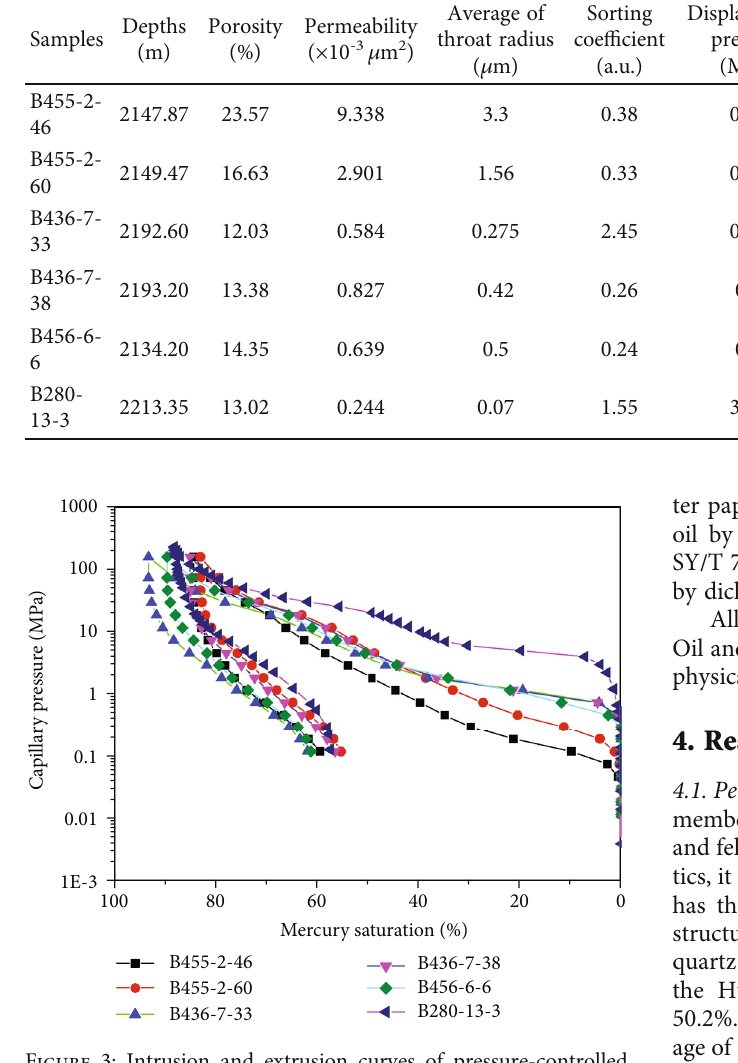
Figure 3: Intrusion and extrusion curves of pressure-controlled porosimetry for six